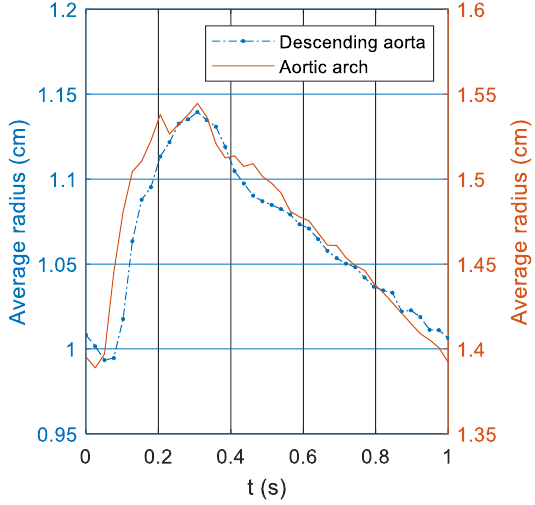
Fig.2: The spatial average time-dependent cross-sectional radius of the aortic arch and the descending aorta during one cardiac cycle.